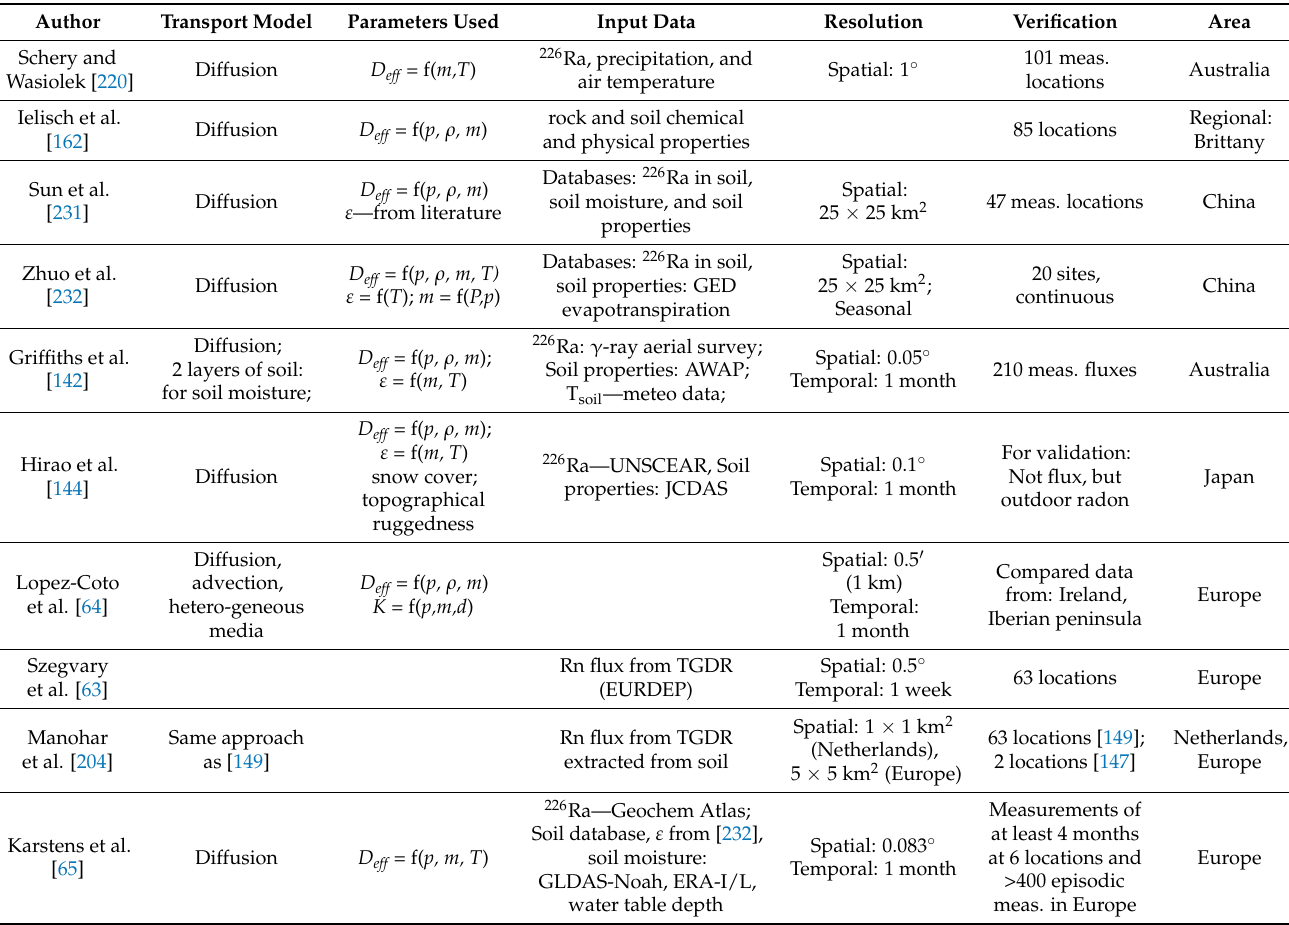
Table 3. An overview of Rn flux models and Rn flux inventories, References related to the databases used for input are given in the text. Explanation of used parameters: D eff —effective diffusion mechanism; p —porosity; ρ —soil bulk density; m —volume fraction of water saturation; ε —emanation coefficient; T —temperature; P —precipitation; K –permeability, d —mean grain